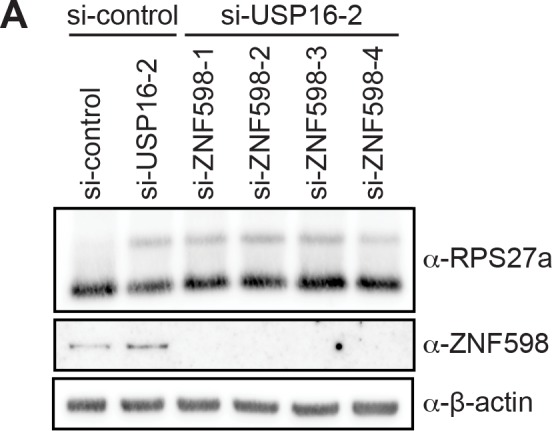
Depletion of the E3 ligase ZNF598 does not affect RPS27a ubiquitination.HeLa cells were treated with control siRNA, a combination of control and USP16-2 siRNA, or a combination of USP16-2 and four different ZNF598 siRNAs for 72 hr. Cell extracts were analyzed by immunoblotting using the indicated antibodies to check for RPS27a ubiquitination and ZNF598 depletion.